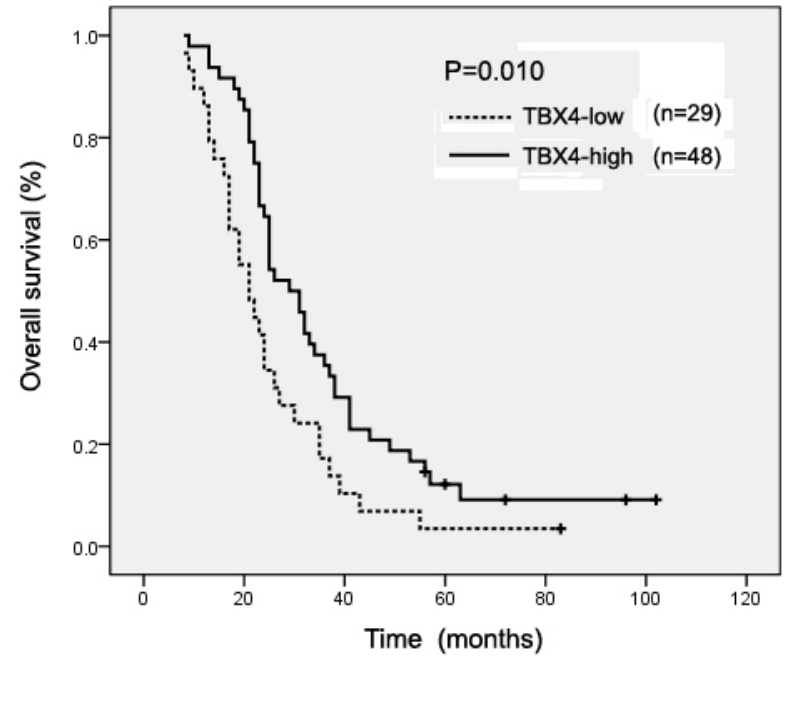
Figure 2. Kaplan–Meier survival curves show that TBX4-low expression PDAC patients had a shorter survival than those with TBX4-high expression. The difference is statistically significant based on the log-rank test (P =